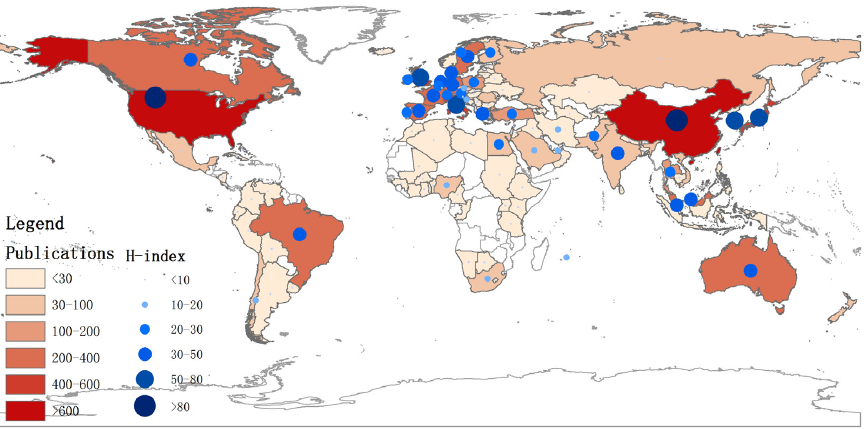
Figure 2. Country/region distribution of the literature.